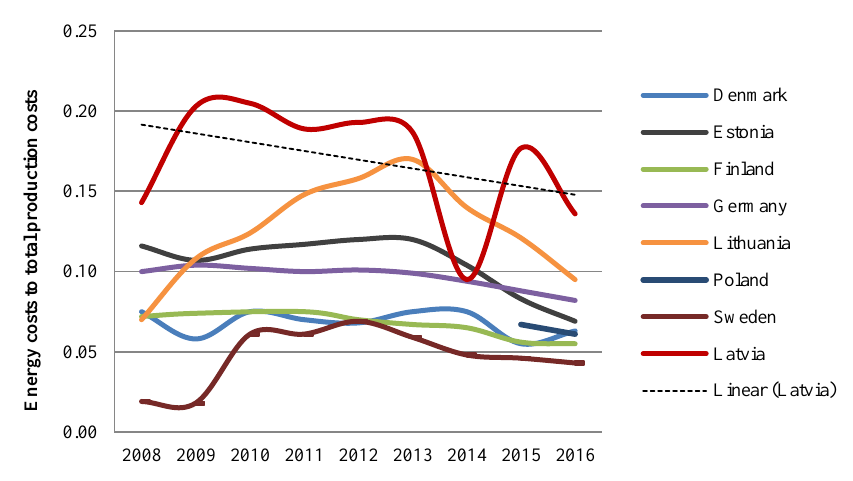
Fig. 7 . Energy costs to total production costs in non-metallic minerals producing industries (Latvia and Baltic Sea region